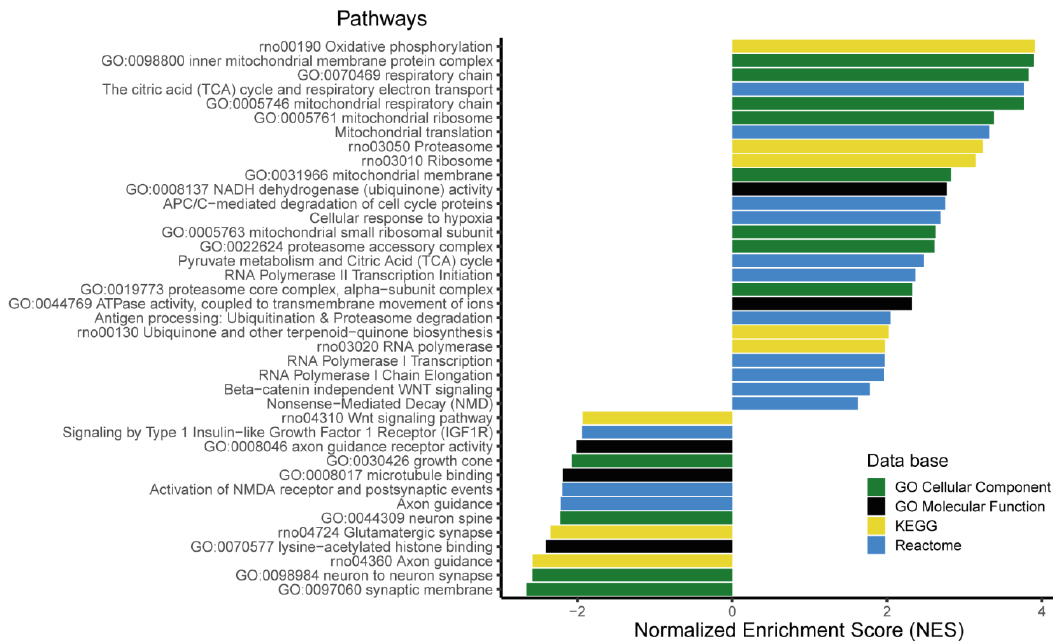
Figure 4. Selection of the gene families and metabolic pathways significantly enriched in differentially expressed genes (Fast Gene Set Enrichment Analysis (FGSEA), padj < 0.05). The pathways with a Normalized Enrichment Score (NES) > 0 are enriched in genes upregulated in the PR group and pathways with an NES < 0 are enriched in genes downregulated in the PR group.